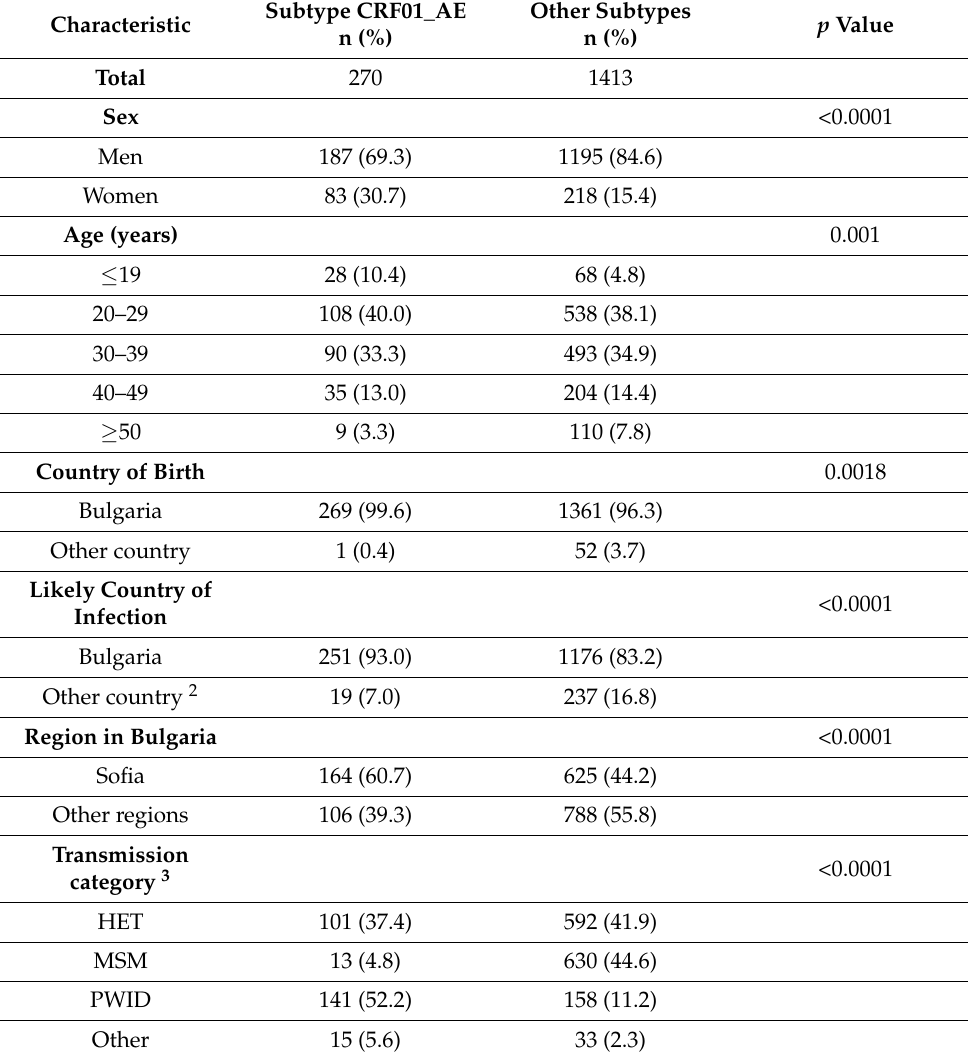
Table 1. Epidemiological characteristics of individuals infected with HIV-1 CRF01_AE compared to infection with other HIV-1 subtypes and circulating recombinant forms (CRFs) in Bulgaria. Subtype CRF01_AE Characteristic n